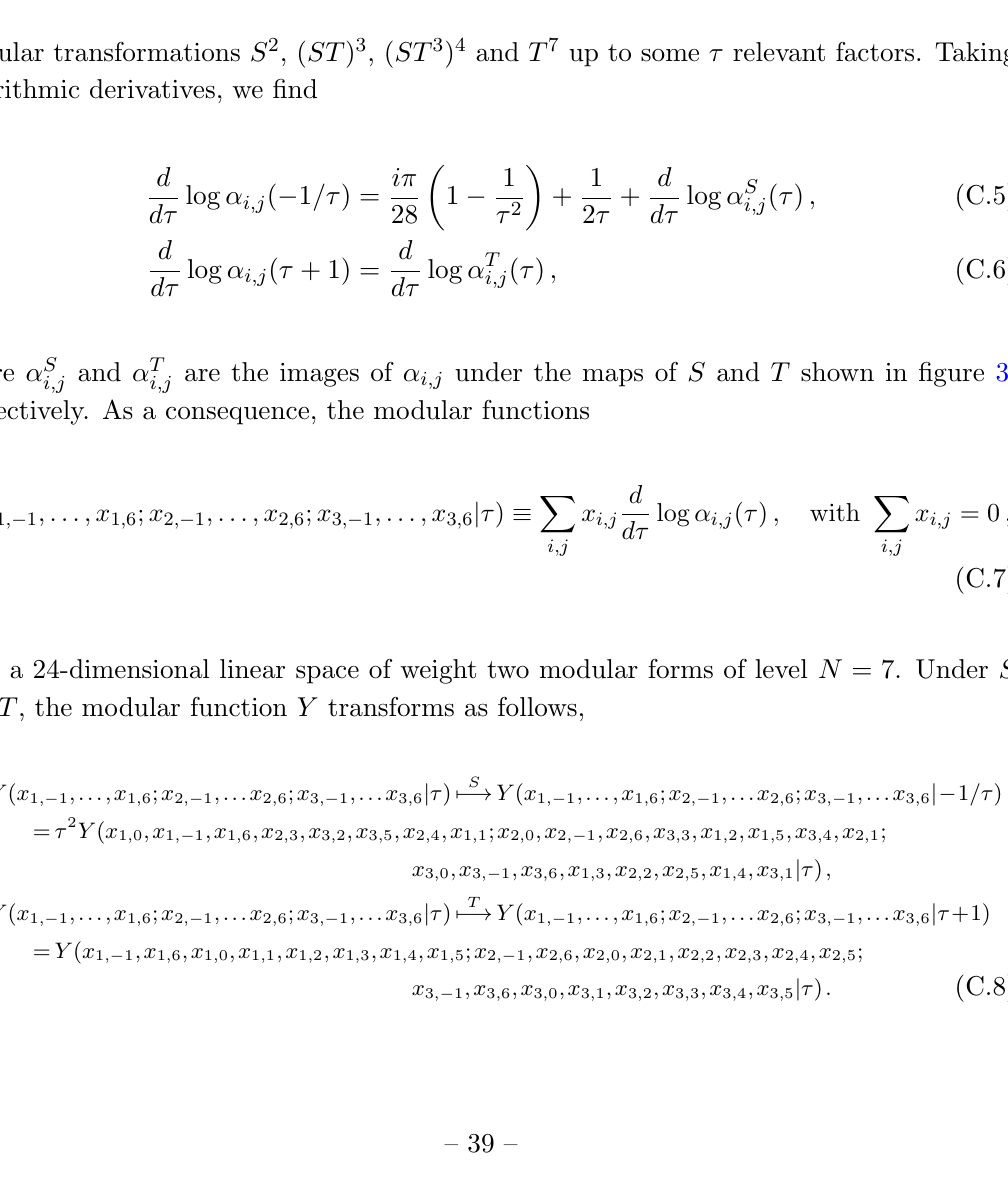
Figure 3 . The graph illustrating the transformations of the set of seed functions (cid:11) i;j ( (cid:28) ), de(cid:12)ned in eq. (C.4), under the actions of (cid:0) 7 (cid:24) = PSL(2 ; Z 7 ) generators S and T . The red and blue solid lines denote the transformations of S and T